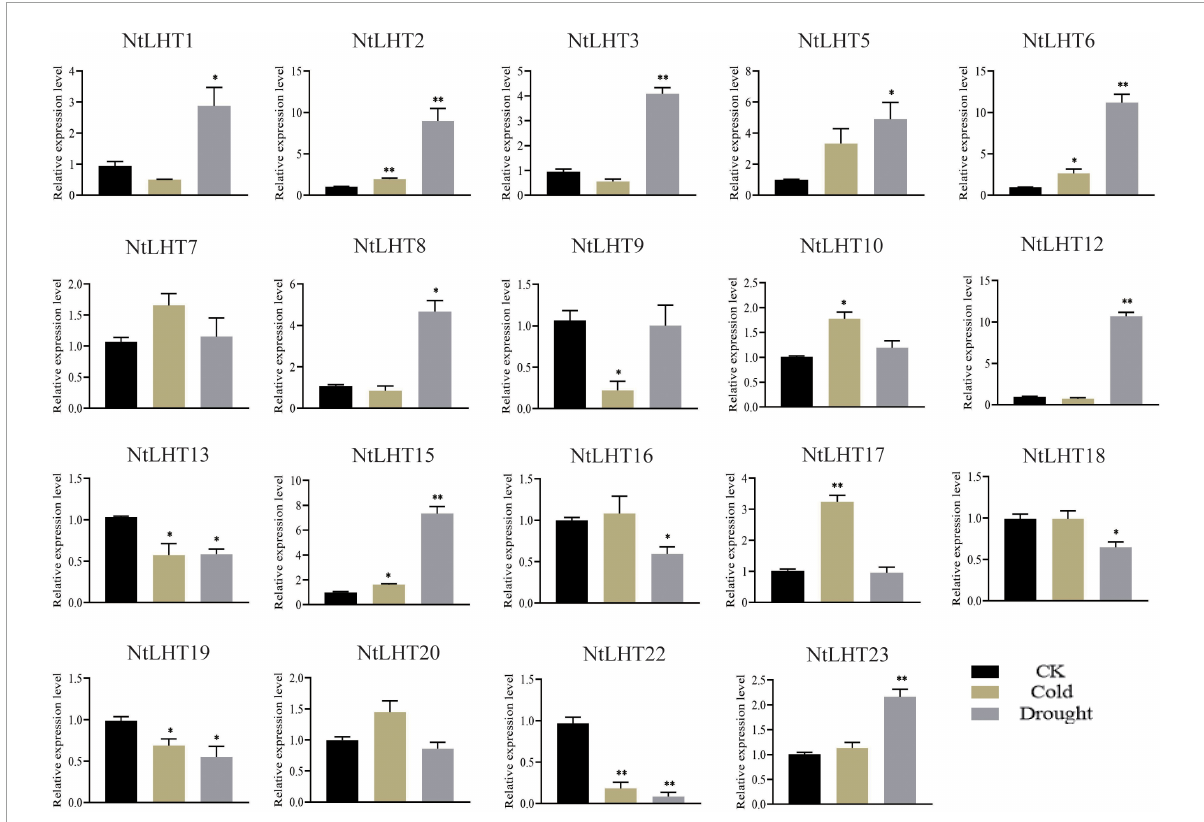
FIGURE7 The expression profiles of NtLHT genes under cold and drought treatments. Seedlings grown under normal conditions used as controls. The data were presented as means ± SDs ( n = 3). Significant differences was detected using Student’s t -test. ∗ P < 0.05, ∗∗ P <